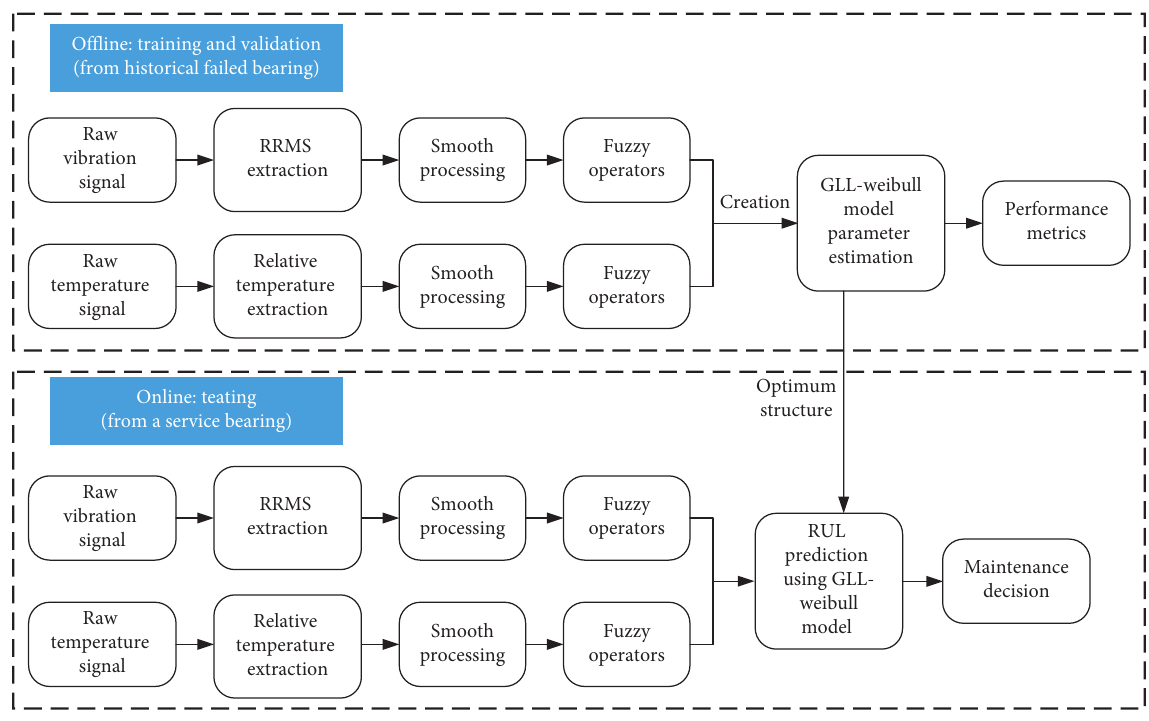
Figure 3: The block diagram of the RUL prediction for rolling bearings.